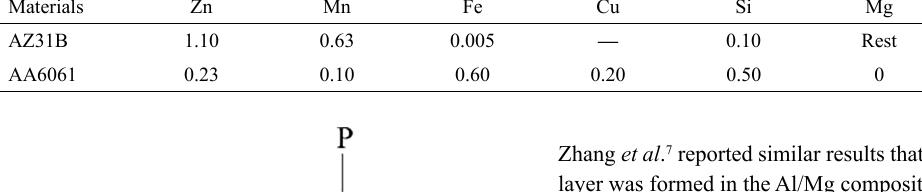
Table 1. Chemical composition of experiment materials used in this study (mass %). Materials